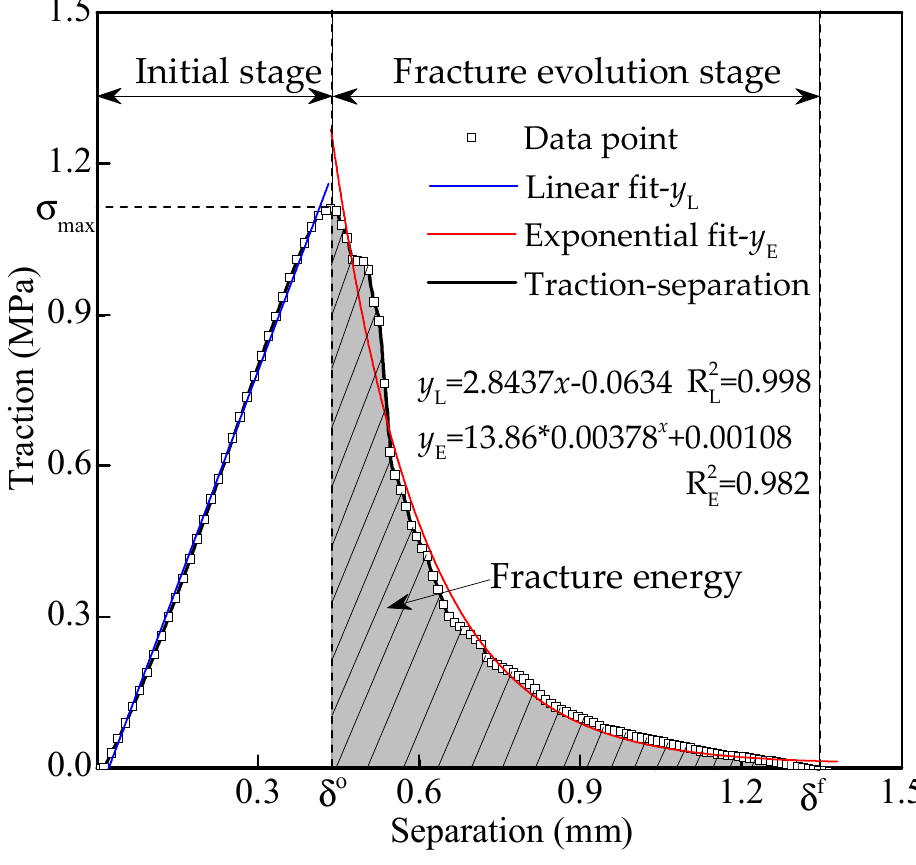
Figure 6. Typical traction-separation curve of beech taken as an example to characterizing fracture behaviors of tested blocks under compact tension laod.